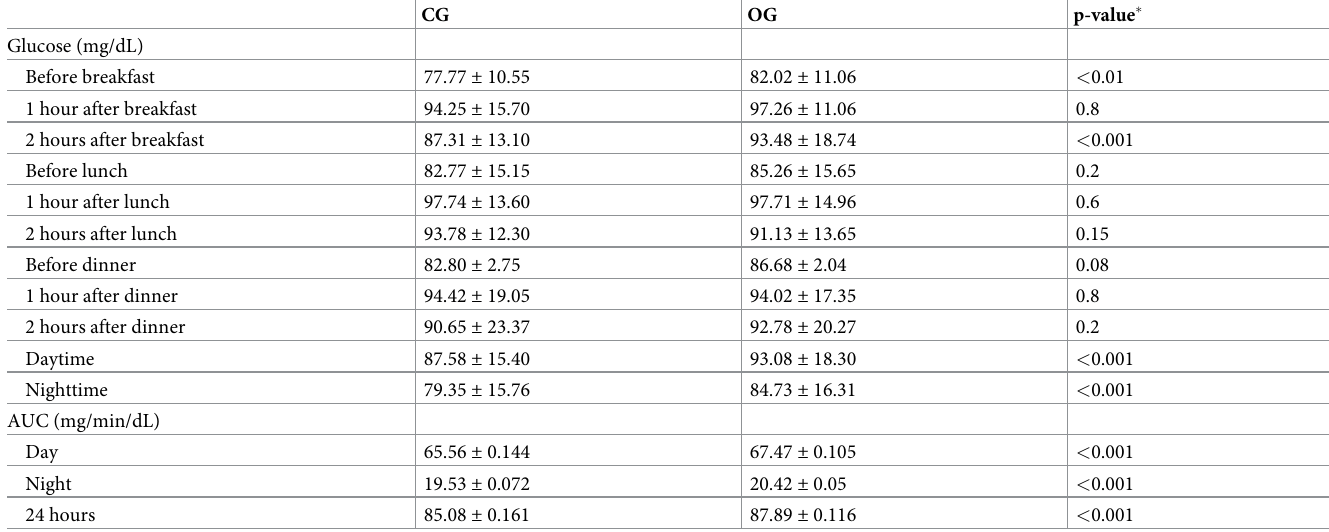
Table 2. Continuous glucose monitoring data in control and obese groups. CG OG p-value � Glucose (mg/dL)